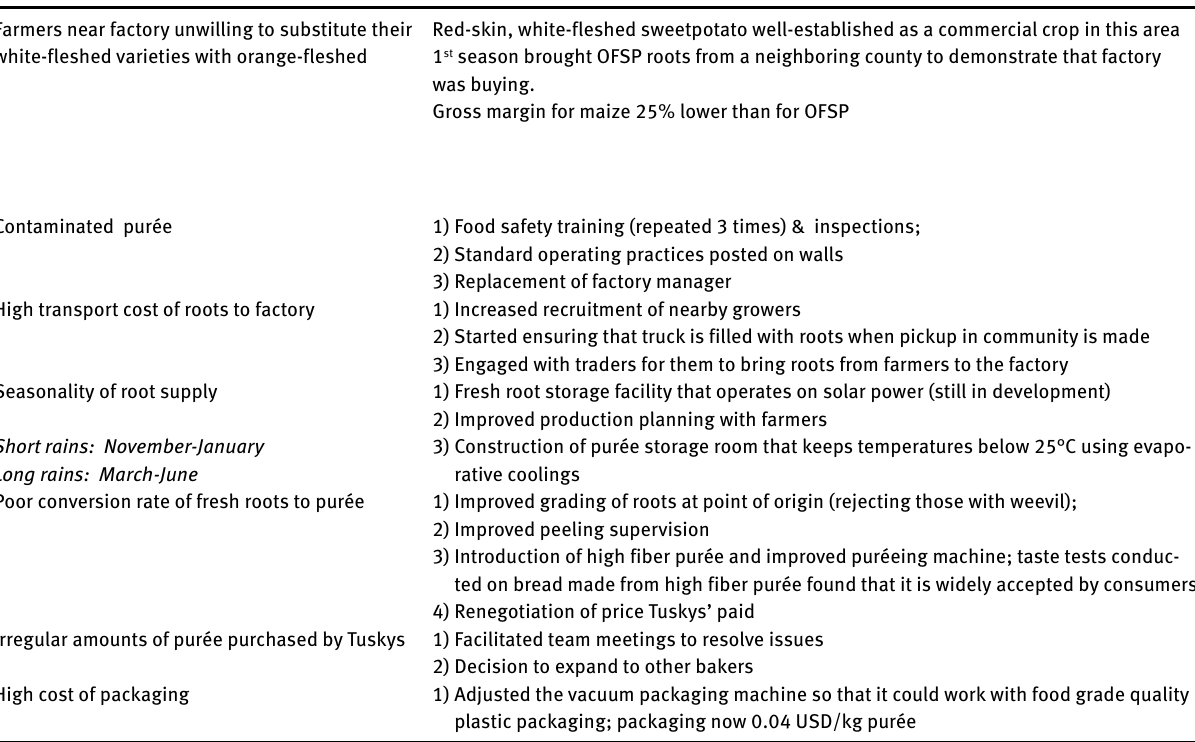
Table 3: Constraints Emerging During Implementation and Their Resolution Emerging constraints Solution(s) Farmers near factory unwilling to substitute their white-fleshed varieties with